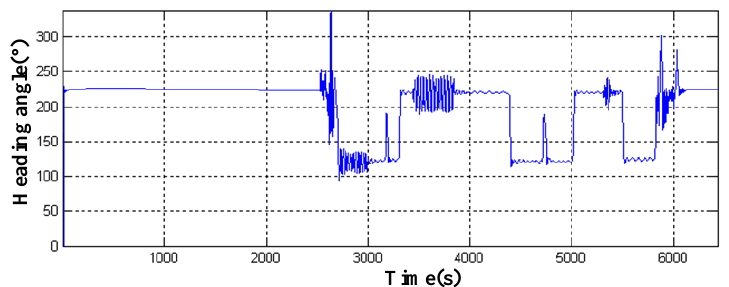
Figure 17. Experiment result of adaptive PID Control in horizon plane.